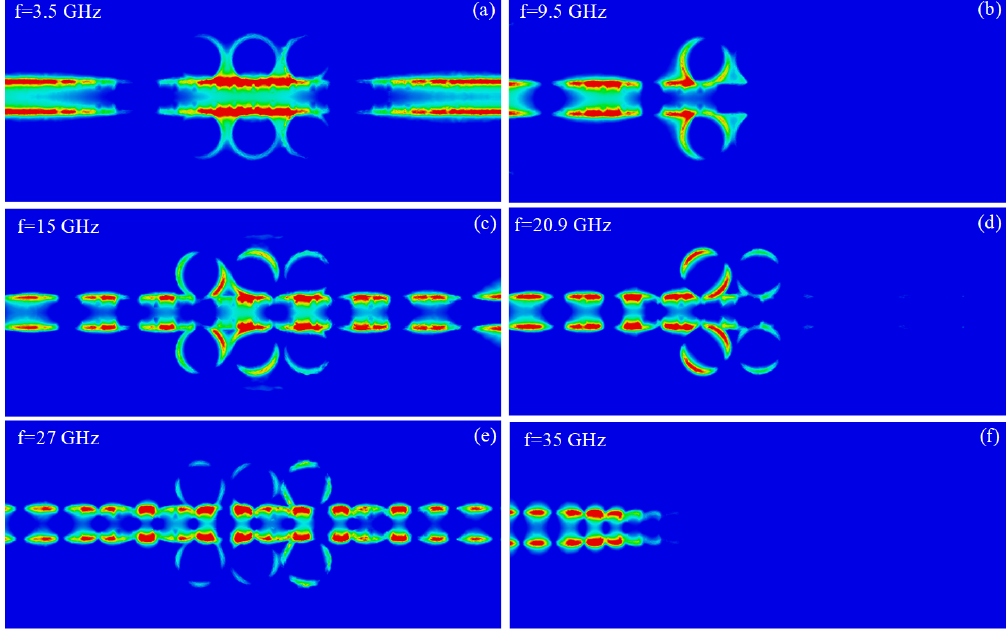
Figure 9. Electric-field distribution of the D-BRF, 0.2 mm above the structure, at different frequencies (in the rejection and pass bands). ( a ) 3.5 GHz, ( b ) 9.5 GHz, ( c ) 15 GHz, ( d ) 20.9 GHz, ( e ) 27 GHz, and ( f ) 35 GHz. Table 1. Performances comparison of the proposed dual band-rejection-filter with traditional SSPP-based ones. The red is shown the advantages of this work, which is wide rejection bandwidth.